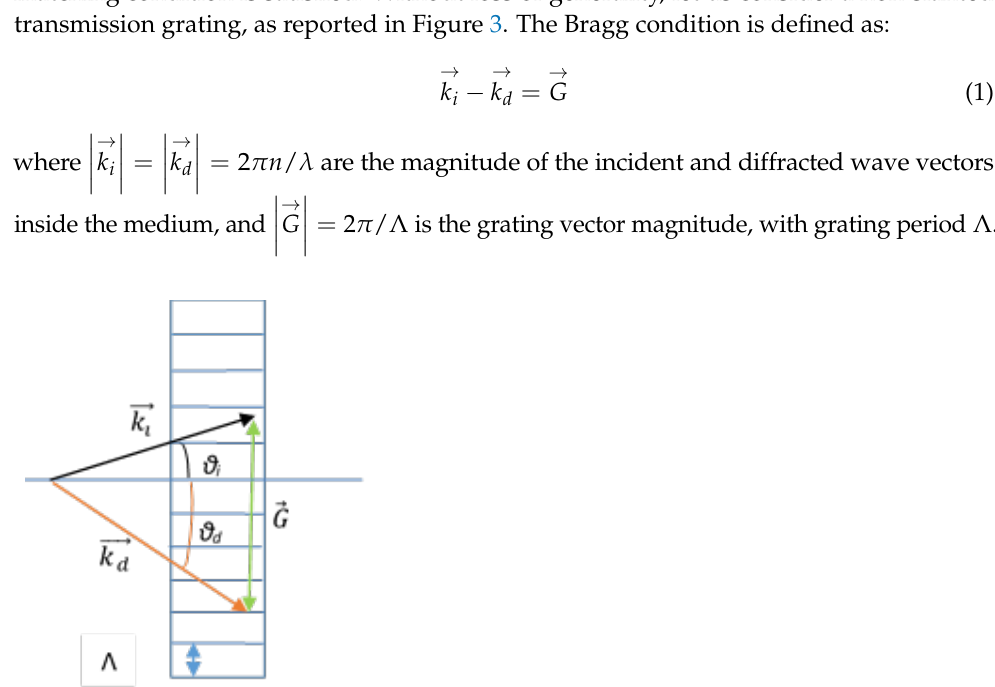
Figure 2. Refractive index (blue line) and extinction coefficient (red line) of the sample extracted from ellipsometric measures.